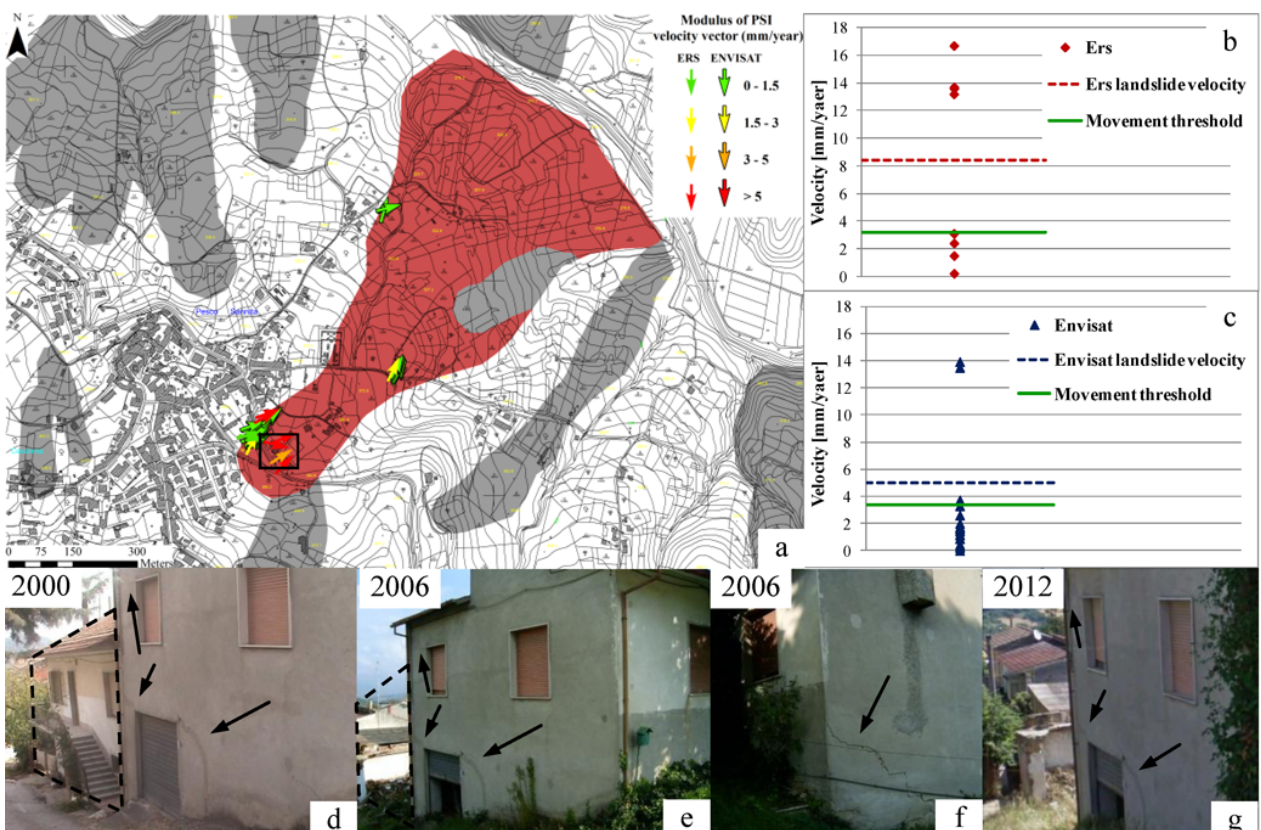
Fig. 22. An active rotational slide-earth flow in the municipality of Pesco Sannita (Benevento Province): (a) the inventory map with ERS/ENVISAT PS velocity vectors; (b–c) diagrams of the ERS/ENVISAT velocity values for the PS located within the landslide boundaries and indication of both the computed landslide velocity and the computed movement threshold; (d–g) photos of two buildings located in the head of the landslide with highlight on the damage recorded during the survey dated 2000, 2006,